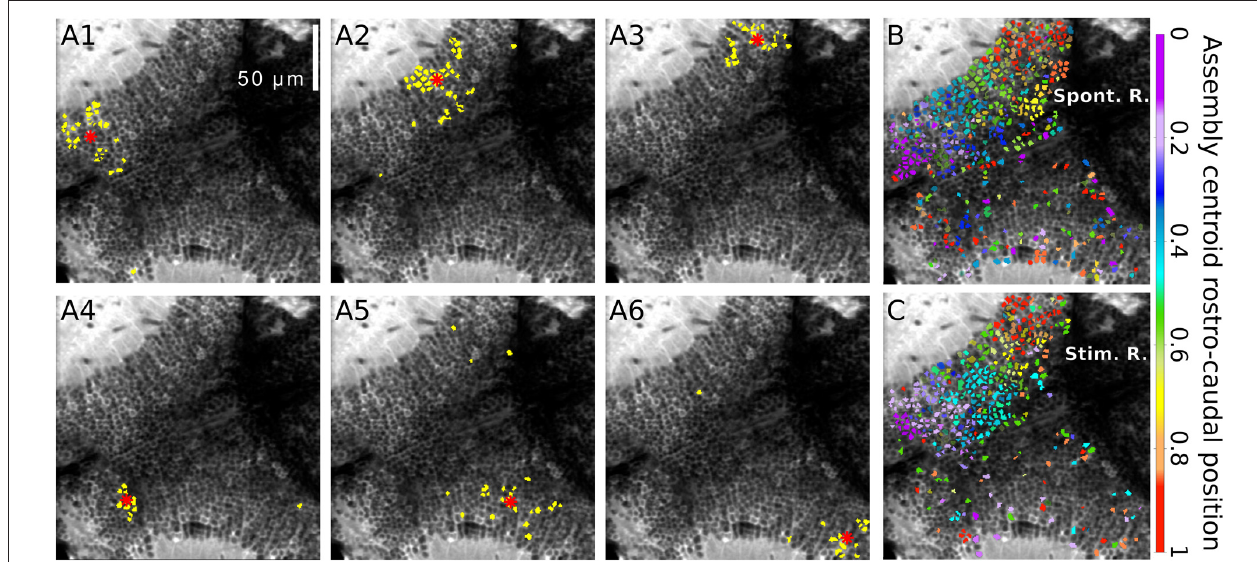
FIGURE 2 | Spontaneously emerging neuronal assemblies. (A1–6) Topographies of six examples of spontaneous neuronal assemblies. The neurons belonging to each of the assemblies are labeled in yellow. Red asterisks: assembly centroids. (B) Example of the spontaneously emerging spatial organization where all the spontaneous assemblies whose centroids lay on the right tectum. Neurons belonging to assemblies with similar topographic centroids were similarly colored. The colors represent the average normalized rostro-caudal centroid position of their assemblies. (C) The same representation for the light-spot-induced responses. Note the resemblance between (B,C) , showing a graded change in colors along the rostro-caudal axes. Scalebars: 50 µ m (reproduced with permission from Romano et al.,